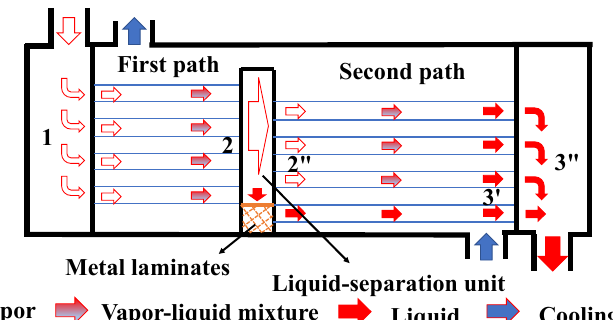
Figure 8. Model of a liquid–vapor separation shell-and-tube condenser [65]. Reproduced with per-mission from Li et al., Applied Energy; published by Elsevier, 2017.